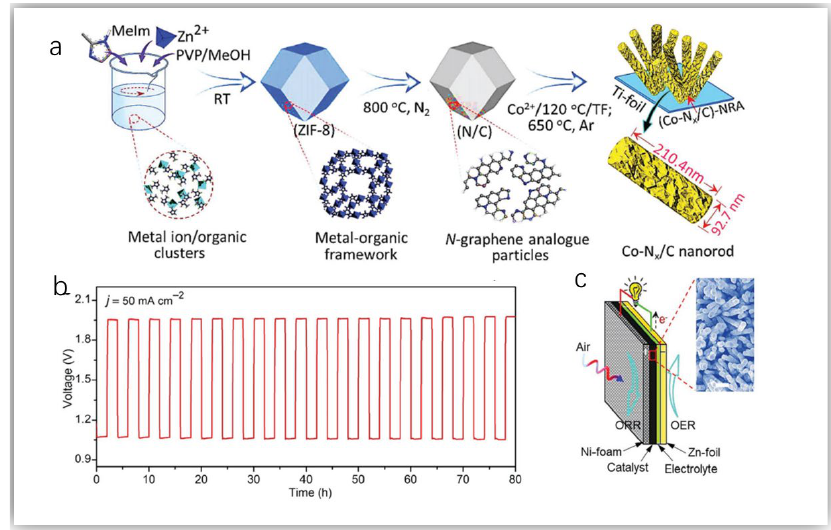
Figure 10. ( a ) Synthesis route for Co-Nx/C nanorod array catalyst, ( b ) discharge-charge cycling profiles of Co–Nx/C NRA catalyst at high current density with a cycling interval of 2 h, ( c ) schematics of home-made all-solid-state zinc–air battery [97]. Reprinted with permission from Ref. [97]. Copyright © 2017 Wiley-VCH Verlag GmbH & Co. KGaA, Weinheim. Zhang et al [98] synthesized an (Ni SAs-NC) electrocatalyst with Ni single atoms uniformly dispersed on N-doped carbon nanosheets (Figure 11a). Electrochemical tests showed that the catalyst had good ORR activity.